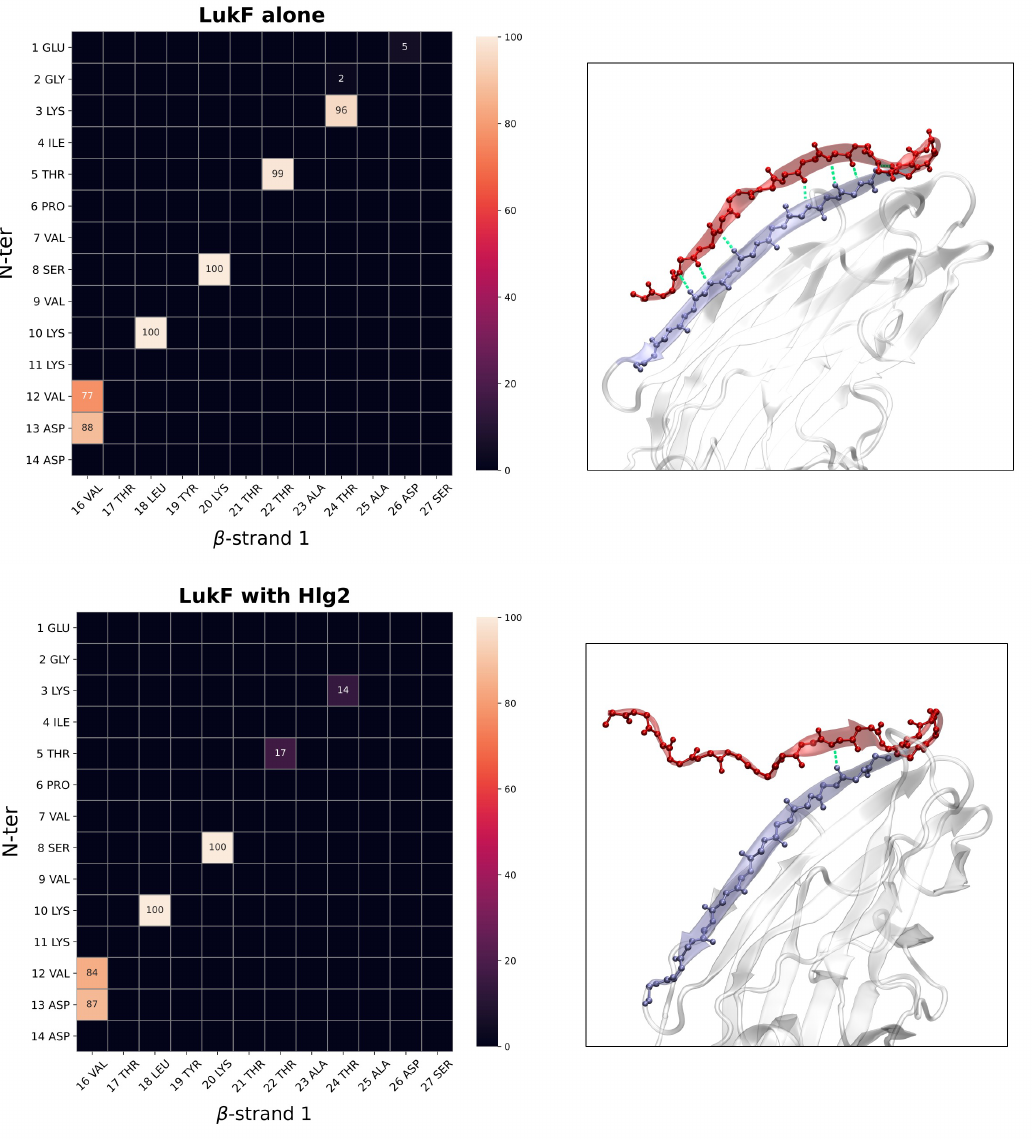
Figure 3. H-bond persistence matrix showing the percentage of simulation frames in which an H-bond contact is formed between the LukF residues (backbone only) of the N-ter and the adjacent beta-strand β 1 . The matrices are reported for the simulation of the single LukF ( top ) and for that showing the spontaneous dimerization on the membrane ( bottom ). A graphical representation of LukF showing the N-term (red) H-bonds in the two simulations is also